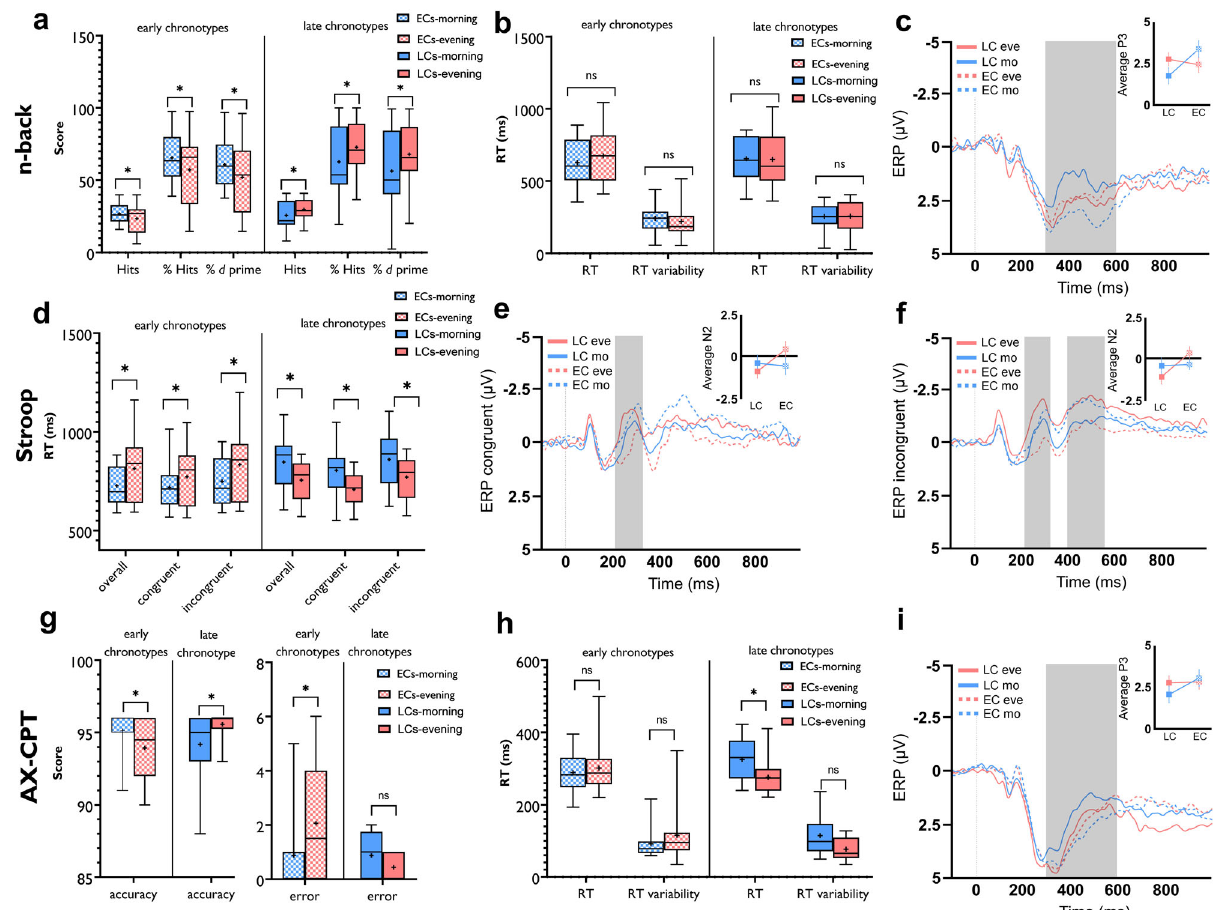
Fig. 5 Association of chronotype with higher-order cognition (working memory and attention). Behavioral and electrophysiological data were analyzed using mixed-factorial (daytime × chronotype) ANOVAs (see Table 3). a ECs had signi fi cantly higher “ Hits ” and percentage of “ Hits ” in the morning vs evening ( t = 2.53, P = 0.023), whereas LCs showed the reverse pattern of results ( t = 2.36, P = 0.032) in the 3-back working memory task. Both groups showed the same pattern for the d prime ( t ECs = 2.55, P = 0.022; t LCs = 2.49, P = 0.025) showing a signi fi cantly higher accuracy percentage and d prime value at their circadian-preferred time. b RT was not signi fi cantly different across time of day in the groups ( t ECs = 1.13, P = 0.275; t LCs = 0.18, P = 0.858). c ECs displayed a larger P300 component in the morning vs evening ( t = 3.62, P = 0.003) and LCs showed a larger P300 in the evening ( t = 2.27, P = 0.038) at electrode Pz. d Both, ECs ( t morning = 1.91, P = 0.074; t evening = 5.88, P < 0.001) and LCs ( t morning = 4.32, P = 0.001; t evening = 5.60, P < 0.001) displayed a stronger Stroop interference effect (RT incongruent − RT congruent ) at their circadian non-preferred time. RT of the congruent, incongruent and overall trials were signi fi cantly slower at the circadian non-preferred time (ECs: t con = 1.66, P = 0.117; t incon = 2.63, P = 0.019; t overall = 3.34, P = 0.004; LCs: t con = 4.13, P = 0.001; t incon = 5.26, P < 0.001; t overall = 5.17, P < 0.001). e , f The N200 amplitude at electrode Fz was calculated in the Stroop stage for both, congruent and incongruent trials. It was larger for both groups at their circadian-preferred times, but the difference was signi fi cant only in ECs ( t con =